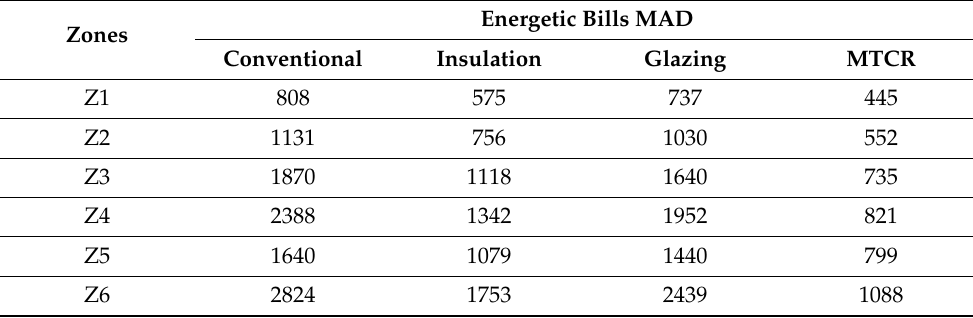
Table 16. Annual energy bill for heating and cooling.